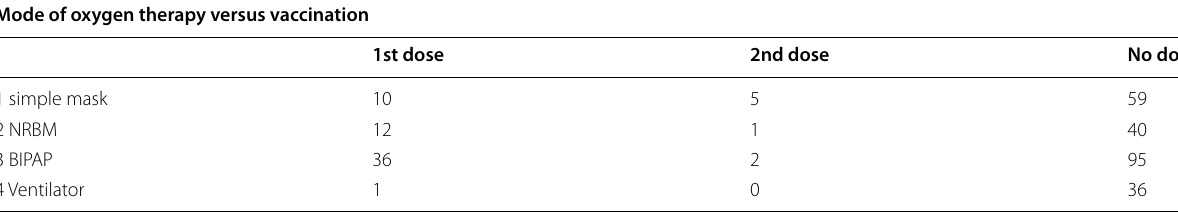
Table 3 Requirement of oxygen therapy in correlation with first, second, and no dose of vaccine ( p value < 0.003)